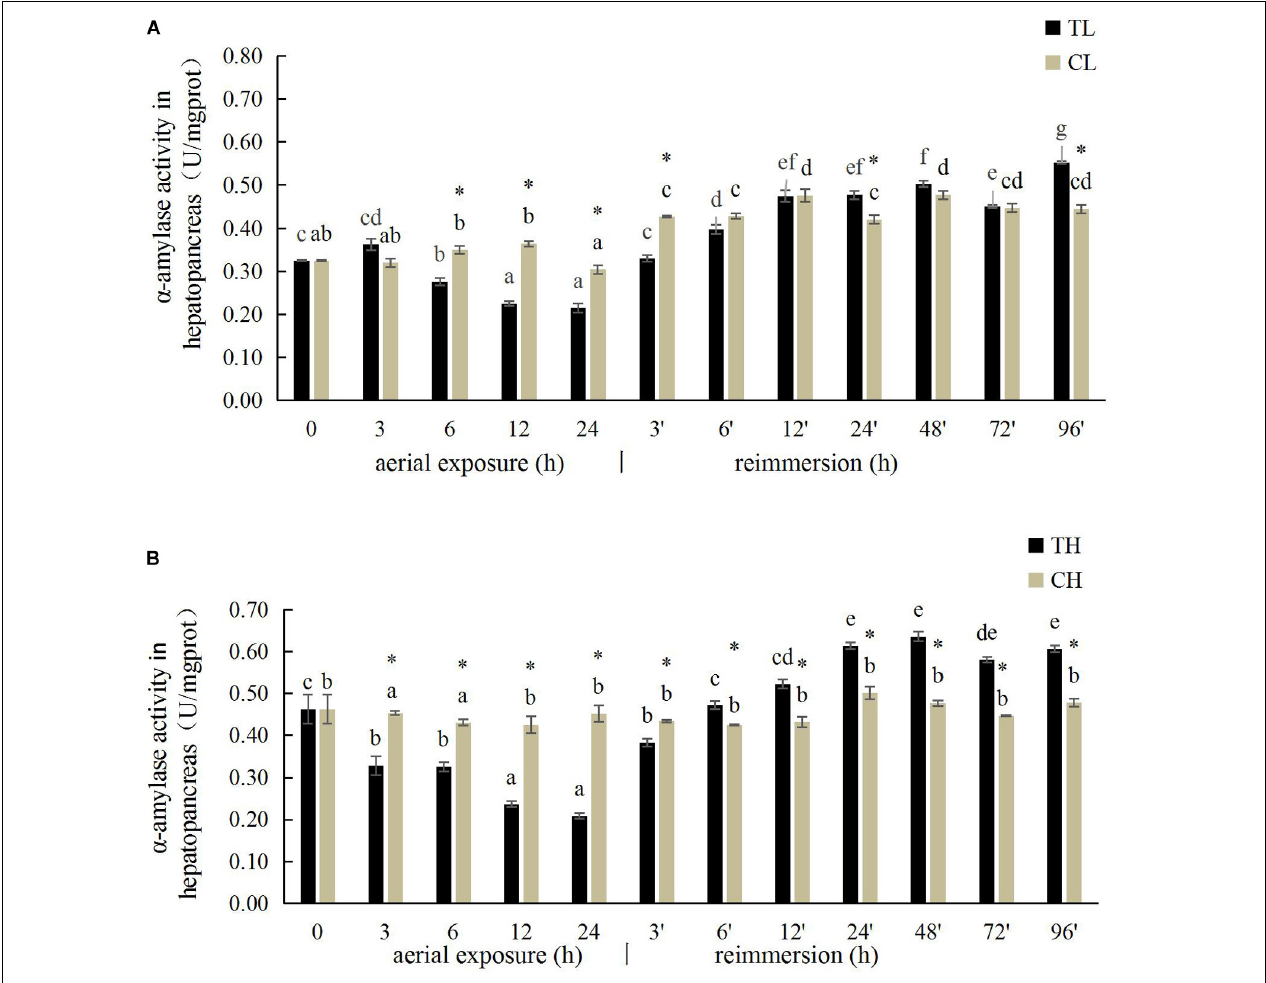
FIGURE 2 | Effects of aerial exposure on α -amylase in hepatopancreas of R. philippinarum under low temperature (A) and high temperature (B)